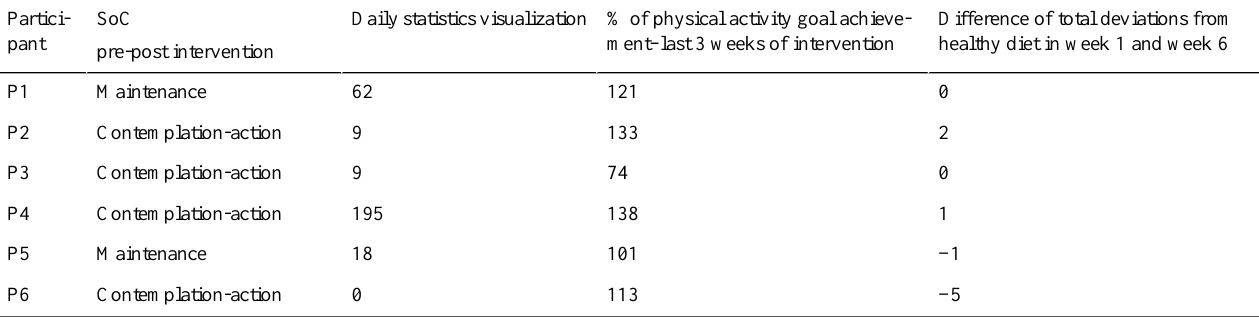
Table 2. State of change (SoC), pre-post intervention, daily statistics visualization, percentage of goal achievement (10 K steps per day) in the last 3 weeks of intervention, difference of total deviations from healthy diet in week 1 and week 6 by participants (n=6).